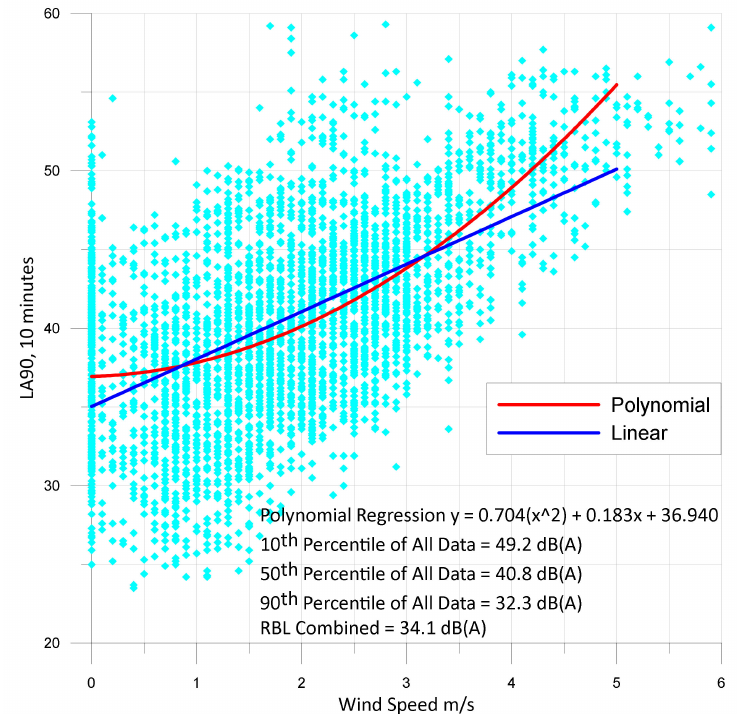
Figure 16. Waubra Wind Farm Regression for SW Wind Quadrant—Post Construction Test, Microphone and wind at 1.5 m AGL.